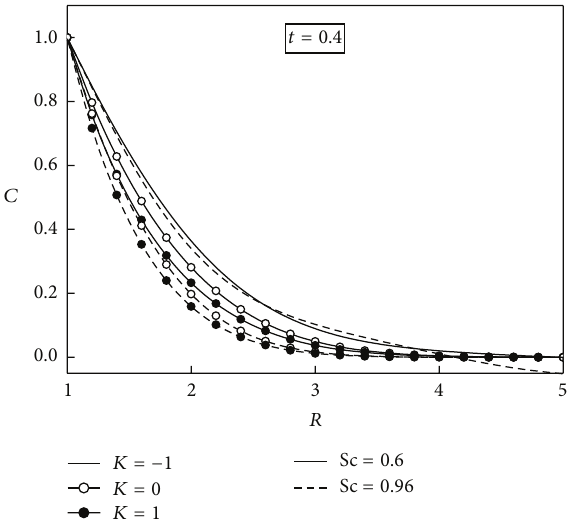
Figure 7: Effects of 𝐾 and Sc on concentration profiles at 𝑡 = 0.4 .